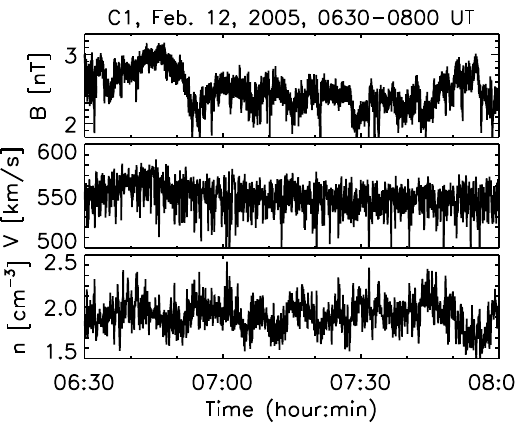
bulk speed, and the ion number density measured by Cluster-1 in the solar